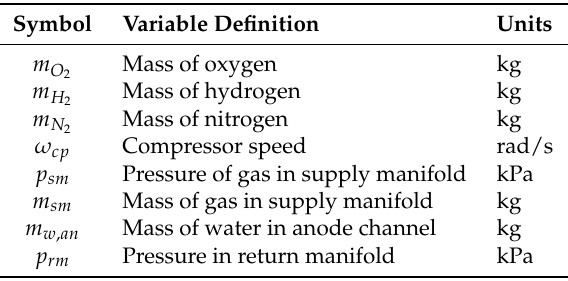
Table 1. PEMFC nomenclature.